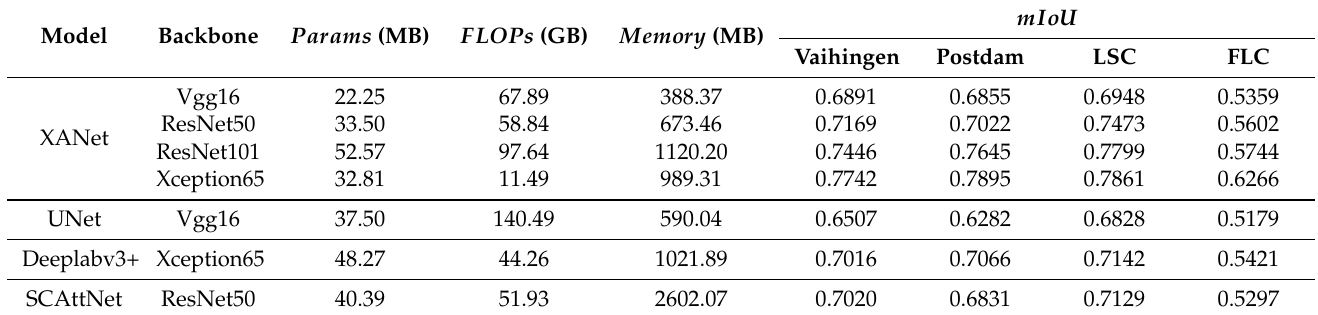
Table 2. Comprehensive comparison of different segmentation models.